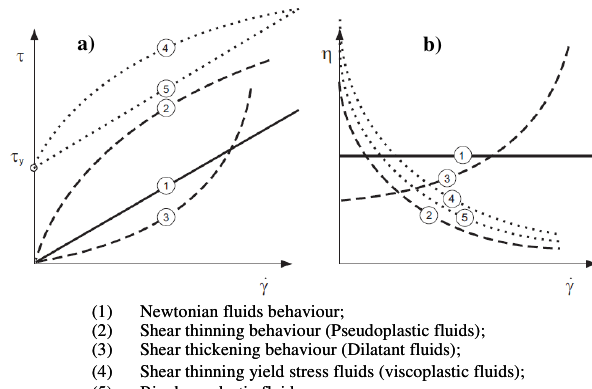
Fig. 1. (a) Flow curves; (b) Viscosity curves.